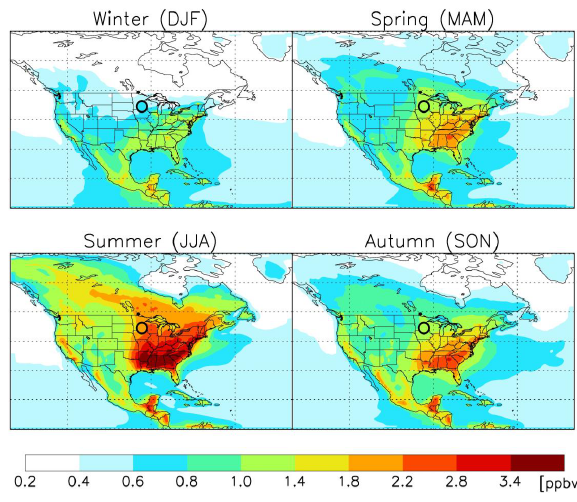
Fig. 1. Surface acetone mixing ratios over the nested North Amer- ican domain (10–70 ◦ N; 140–40 ◦ W) in the GEOS-Chem a pri- ori simulation for the year 2010. A sub-domain (13–70 ◦ N; 140– Figure 1. Surface acetone mixing ratios over the nested North American domain (10-70°N; 140- 4 50 ◦ W) is used in the paper for computing North American source 40°W) in the GEOS-Chem a priori simulation for the year 2010. A sub-domain (13-70°N; 140- 5 magnitudes. Measured mixing ratios at the KCMP tall tower 50°W) is used in the paper for computing North American source magnitudes. Measured mixing 6 (44.689 ◦ N, 93.073 ◦ W) are indicated by the filled circle on the ratios at the KCMP tall tower (44.689°N, 93.073°W) are indicated by the filled circle on the 7 same color same color scale. 8